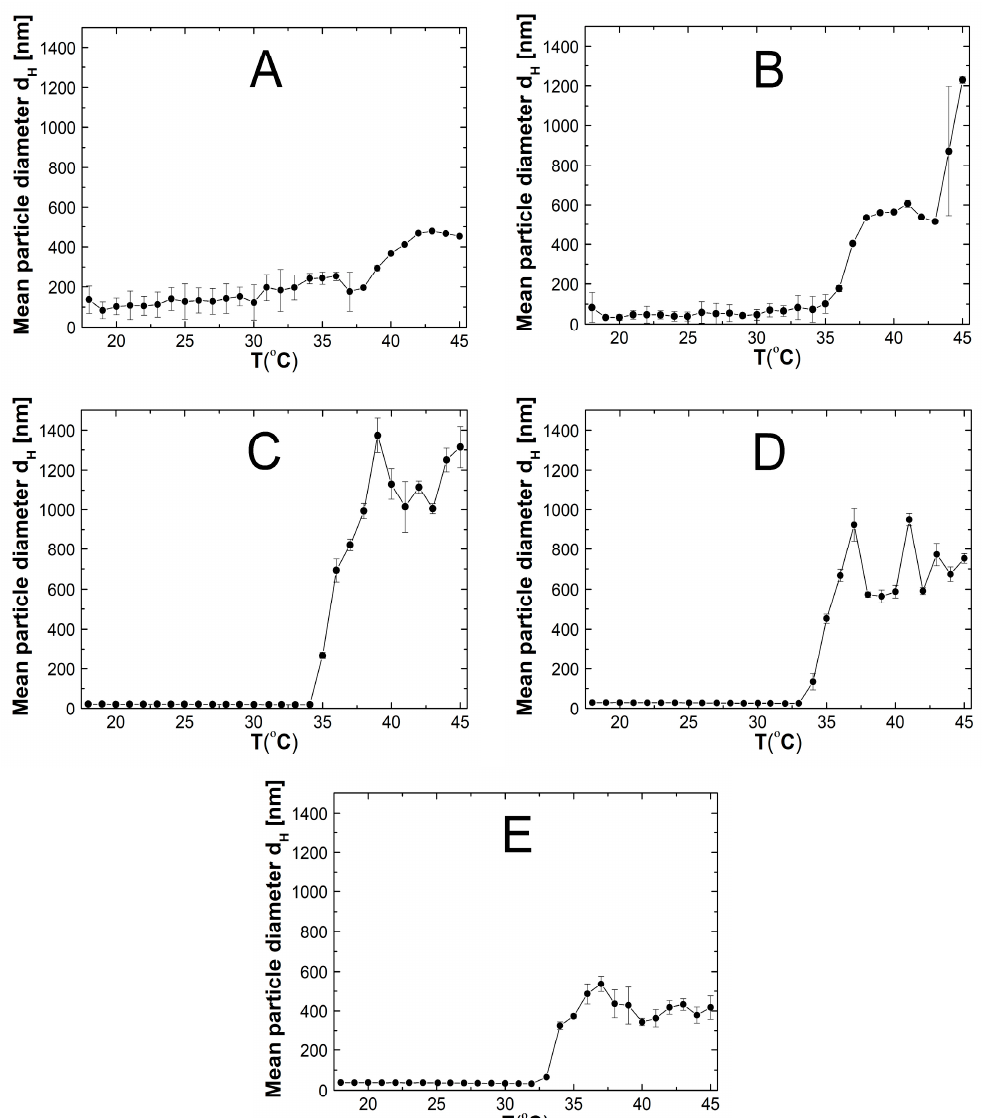
Figure 7. The effect of the temperature on the hydrodynamic diameter of the prepared particles P1 ( A ), P2 ( B ), P3 ( C ), P4 ( D ), and P5 ( E ) .